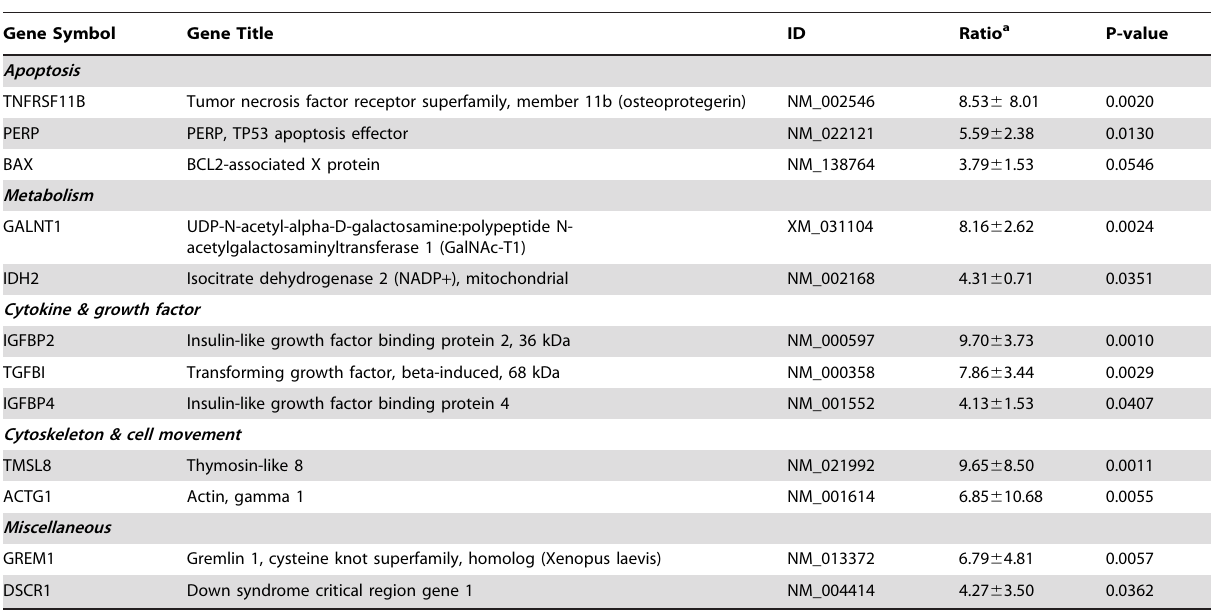
Table 1. Differently expressed genes identified by